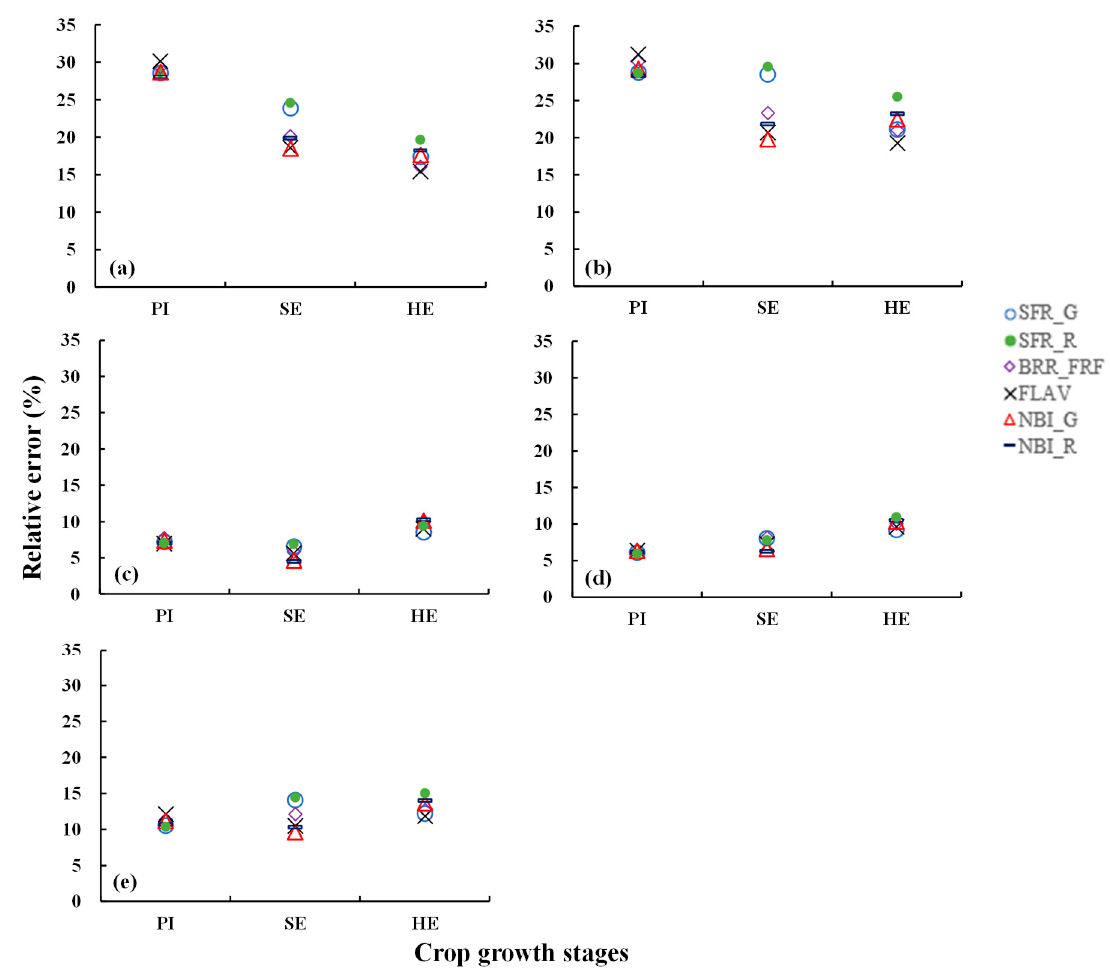
Figure 3. The relative error (RE) values of the validation analysis based on the regression models of the six Multiplex indices and the N status indicators for ( a ) above-ground biomass (AGB), ( b ) plant N uptake (PNU), ( c ) leaf N concentration (LNC), ( d ) plant N concentration (PNC), and ( e ) nitrogen nutrition index (NNI) at the panicle initiation (PI), stem elongation (SE), and heading (HE) stages.